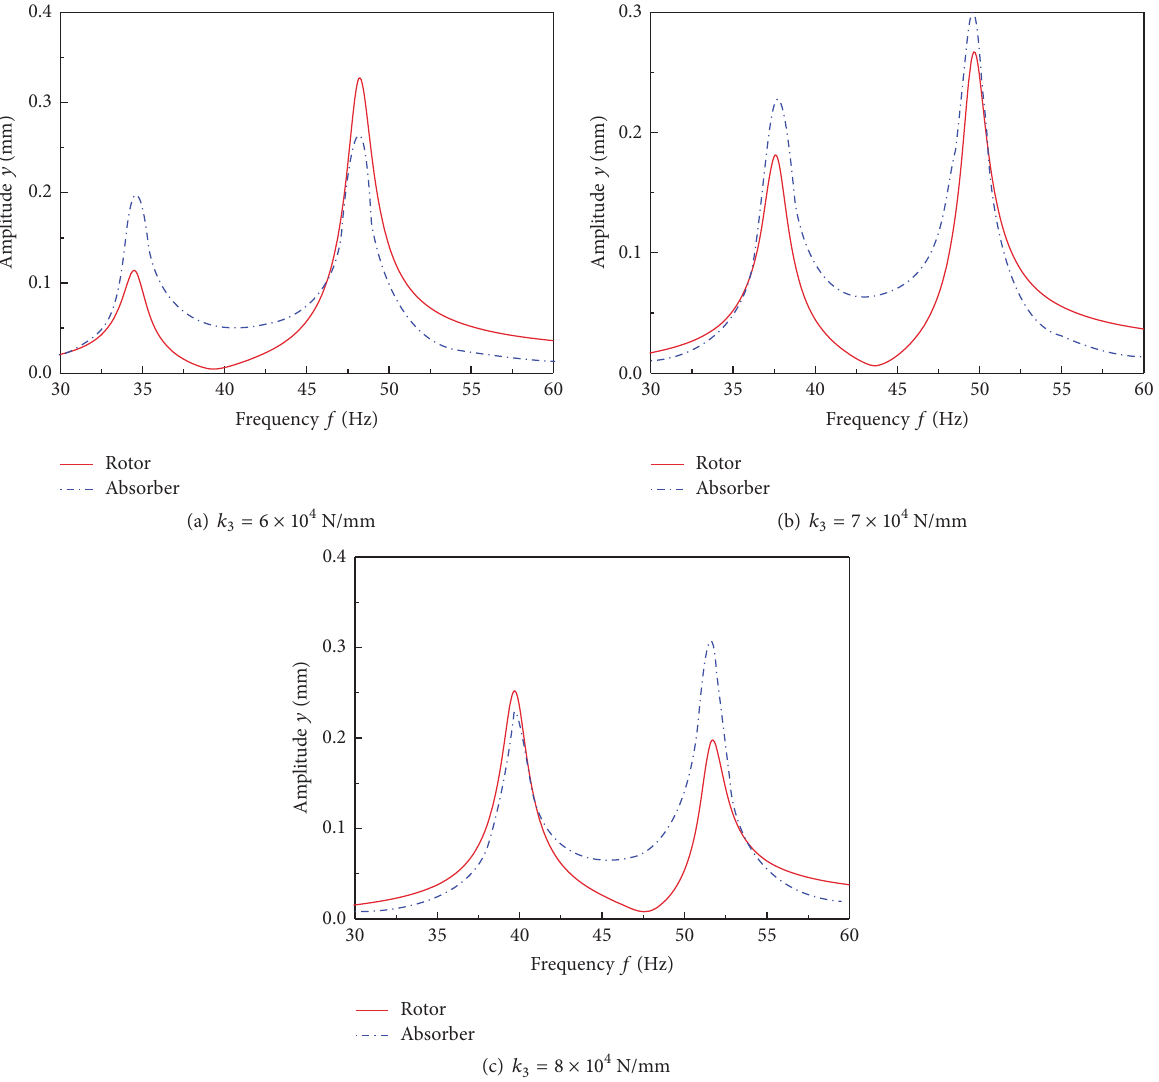
Figure 9: Responses of the rotor-absorber system when ℎ is